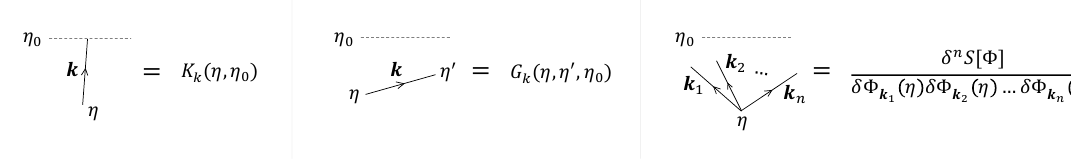
Figure 2 . A graphical representation of the Feynman rules to compute the wavefunction of the universe in perturbation